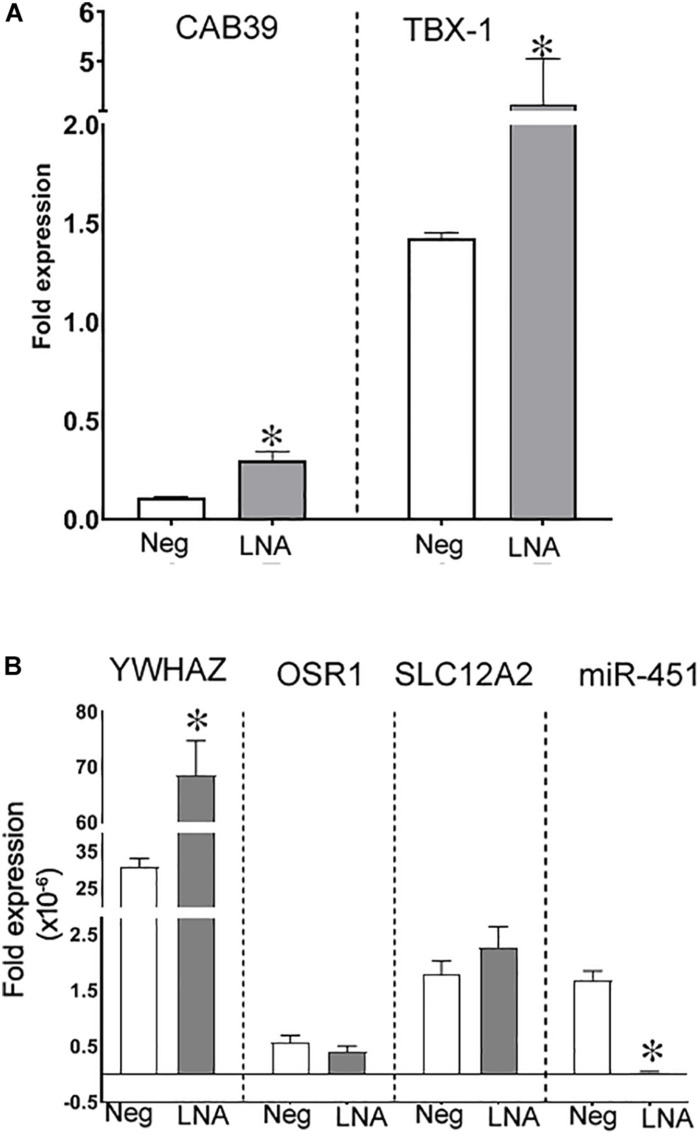
Inhibition of miR-451 in primary human proximal tubule (hPT) cells. Fold expression of (A) CAB39 and TBX1 and (B) YWHAZ, OSR1, SLC12A2, and miR-451 in hPT cells transfected either with hsa-LNA-miR-451a-inhibitor or with hsa-LNA-miR-451a-inhibitor control (negative control). Transcript levels of genes of interest were normalized against 18S ribosomal RNA using the formulae 2–ΔC. All values are represented as mean ± SEM. *p < 0.05 was considered significant by unpaired t-test.